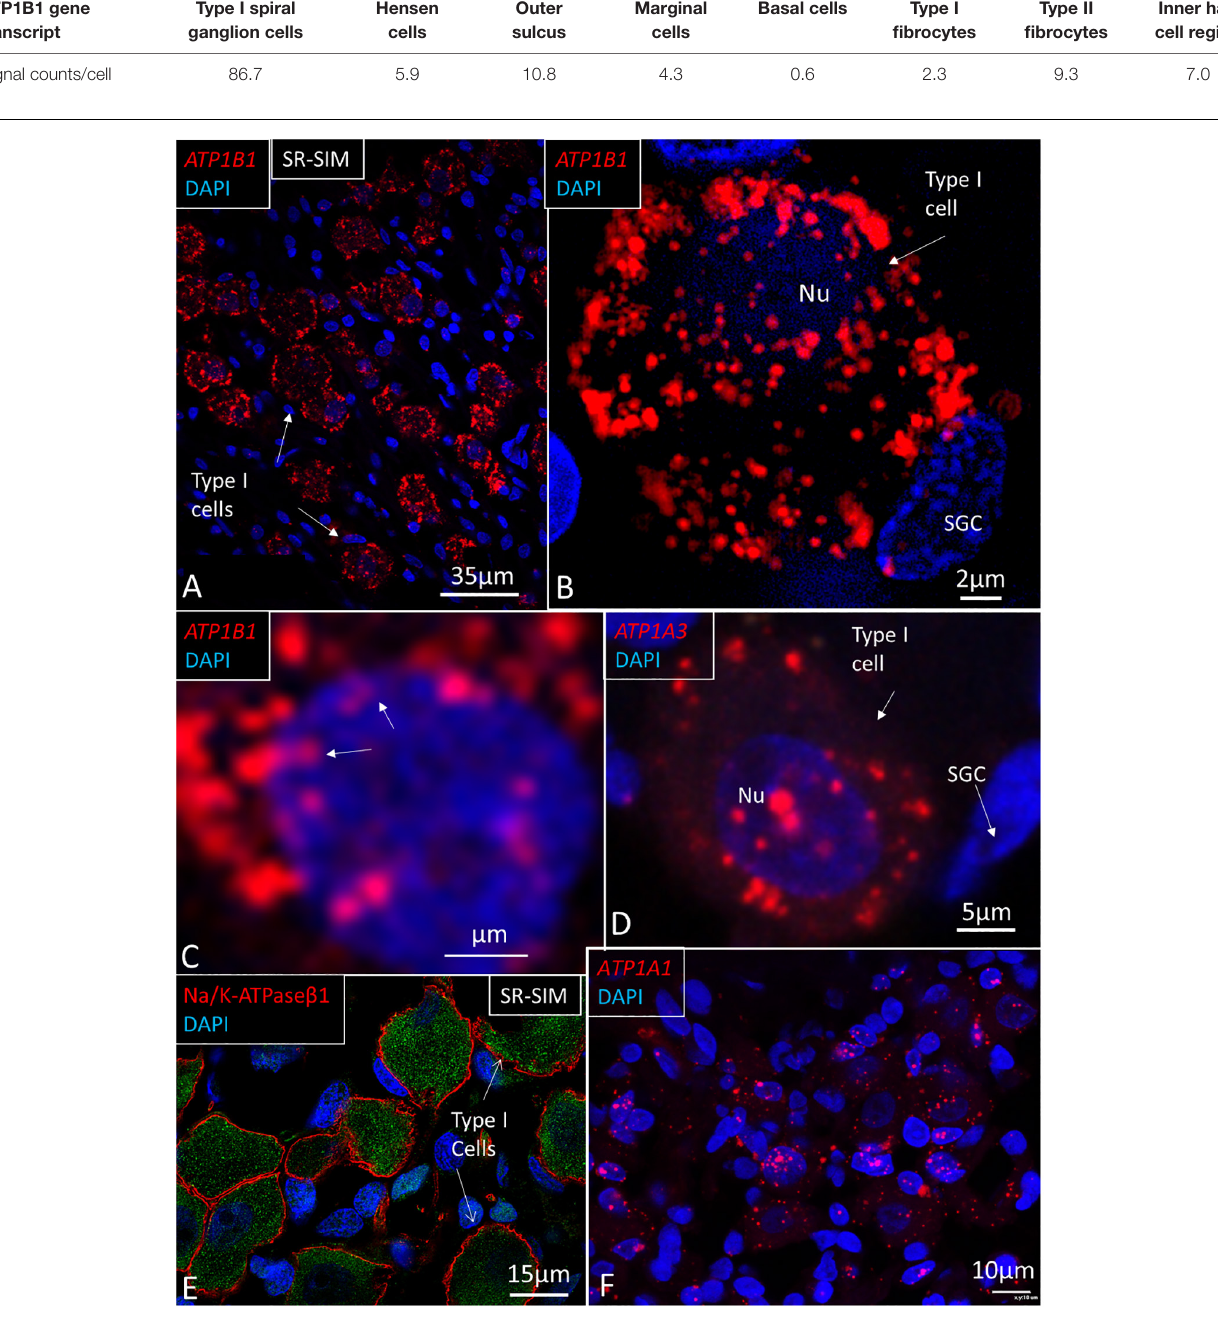
TABLE 2 | Results of quantitative analysis of ATP1B1 signal counts per cell in different cellular domains of the human cochlea. ATP1B1 gene transcript